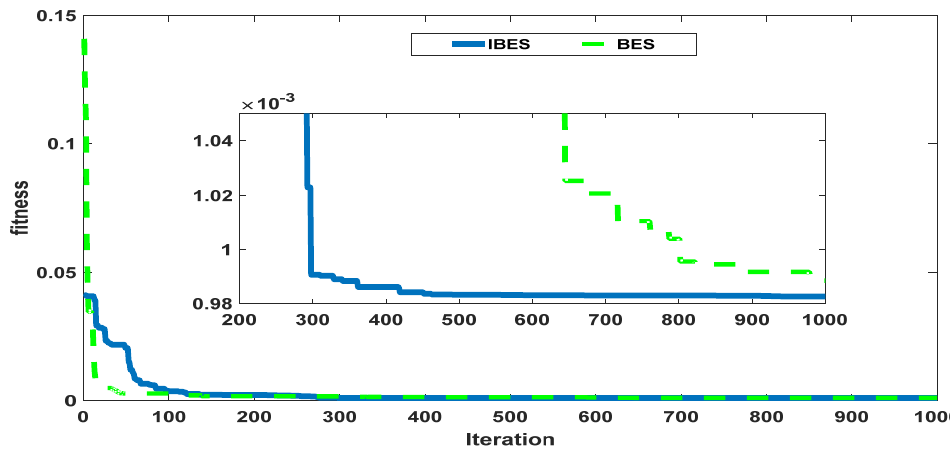
(21) Table 6. Results of the IBES and BES for the MTDM and TDM for a furnace. Algorithm